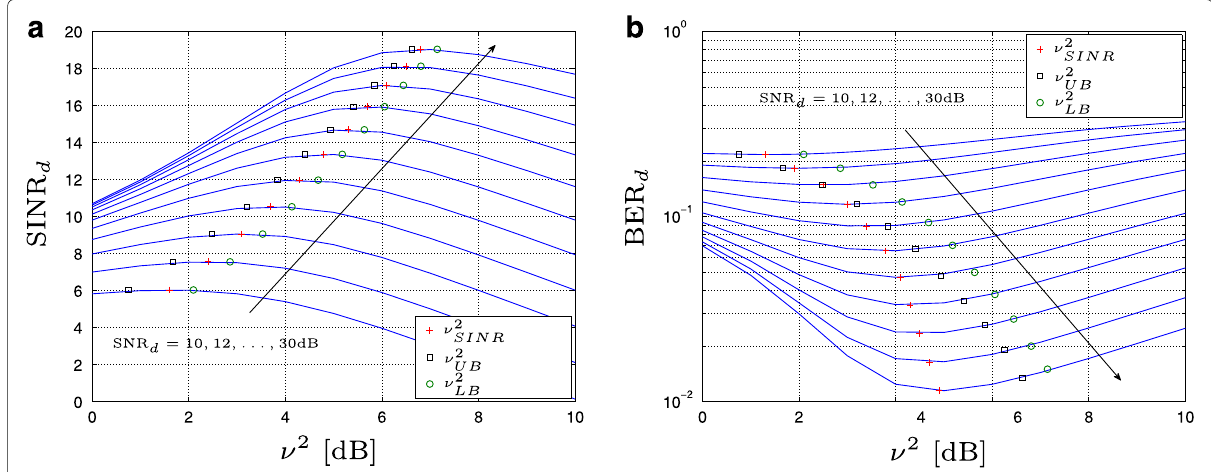
Fig. 2 Maximization of SINR a and minimization of BER b for the SL model and SNR d = 10,12, ... ,30 dB. Rayleigh relay-destination channel